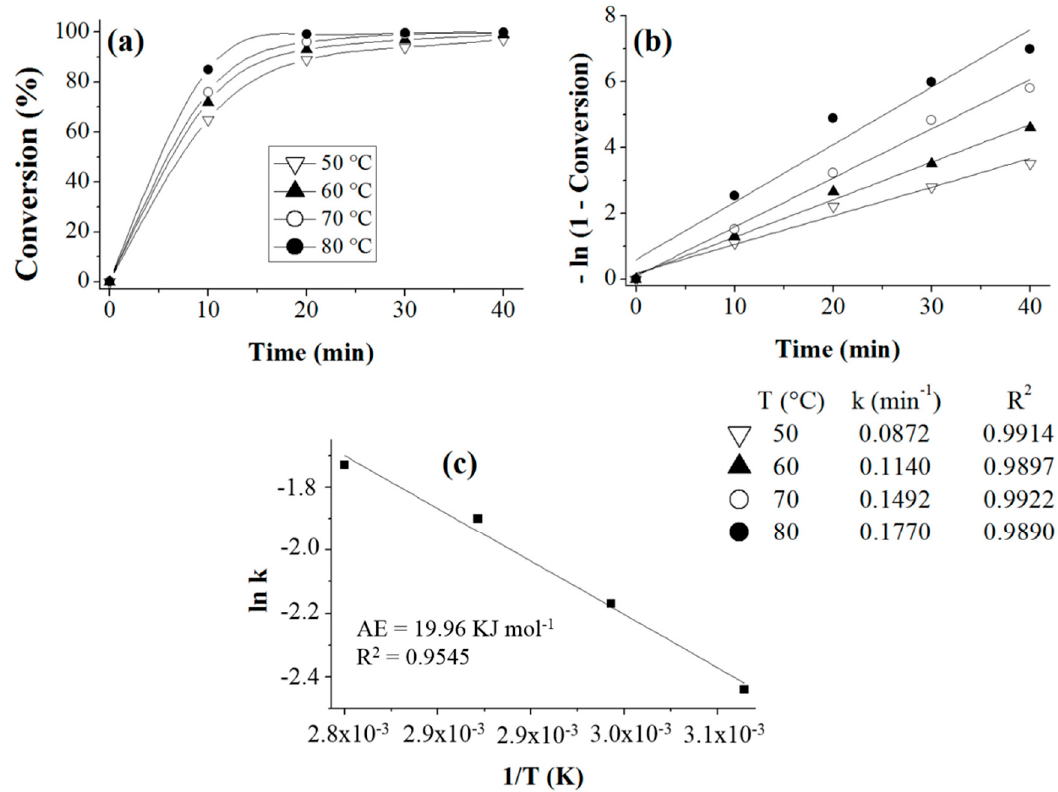
Figure 11. Kinetic study of the conversion of eugenol to the catalyst ( a ); kinetic plot of − ln (1 − conversion) versus time at different temperatures for calculations of velocity constants and reaction order analysis, where ( b ); Arrhenius graph for calculating the activation energy for eugenol acetylation reaction at different temperatures on the catalyst ( c ).